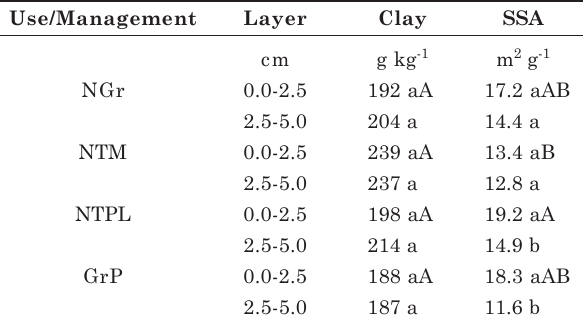
Table 1. Amounts of clay and specific surface area (SSA) in two layers of a Rhodic Paleudult under four land use and management